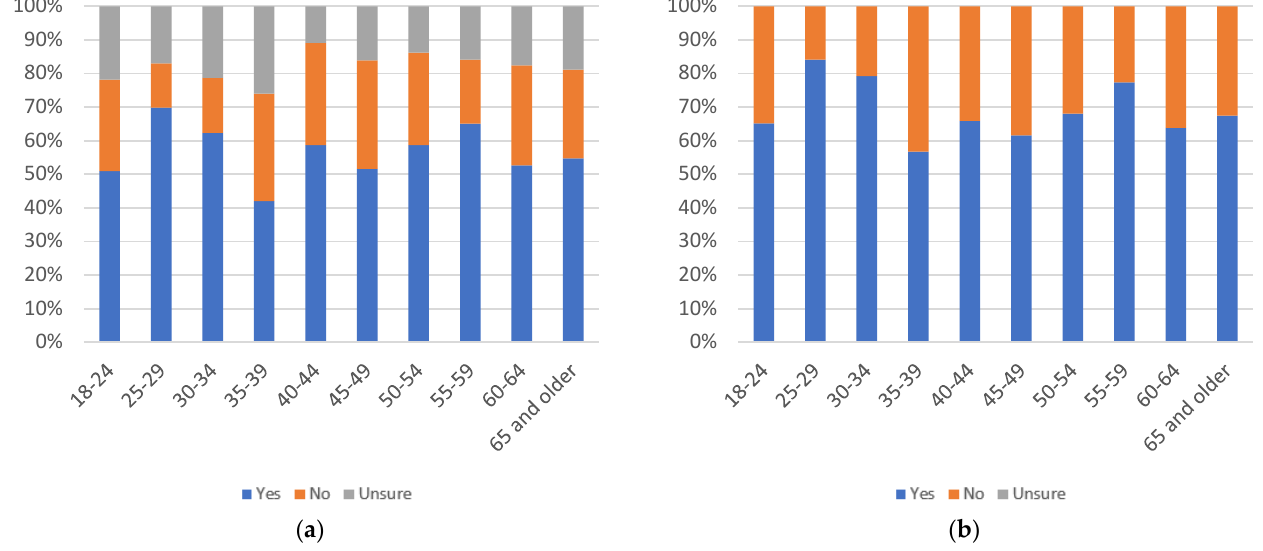
Figure 81. Label trustworthiness judging use, by age group: ( a ) with uncertain respondents (left) and ( b ) without uncertain respondents (right).